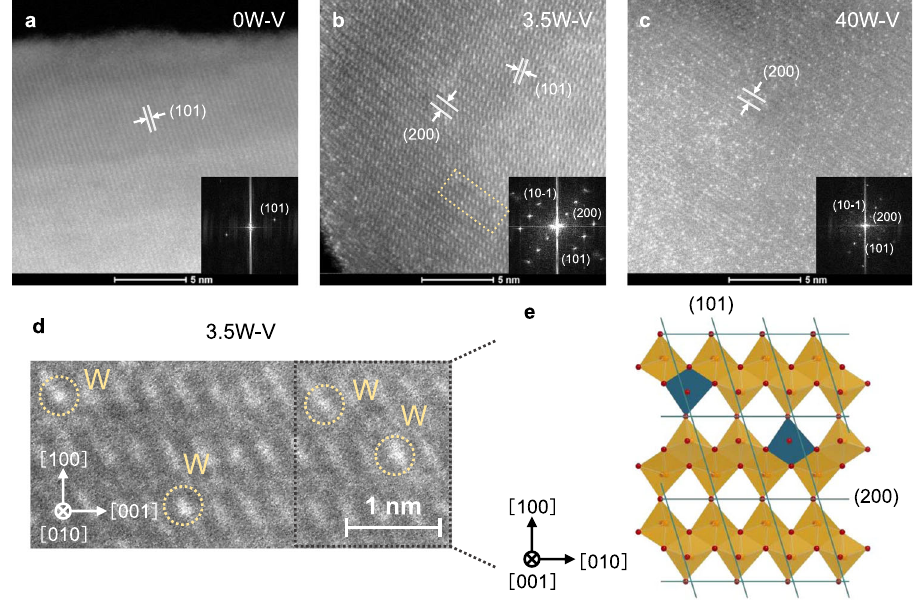
Fig. 1 Direct observation of tungsten substitution. HAADF-STEM images of a 0, b 3.5, and c 40 mol% W-substituted vanadium oxide (0, 3.5, and 40W – V). Insets: corresponding FFT images. d Enlarged view of the yellow region in ( b ). e Crystal structure of W-substituted vanadium oxide. Orange polyhedra: vanadium units; blue polyhedra: tungsten units.